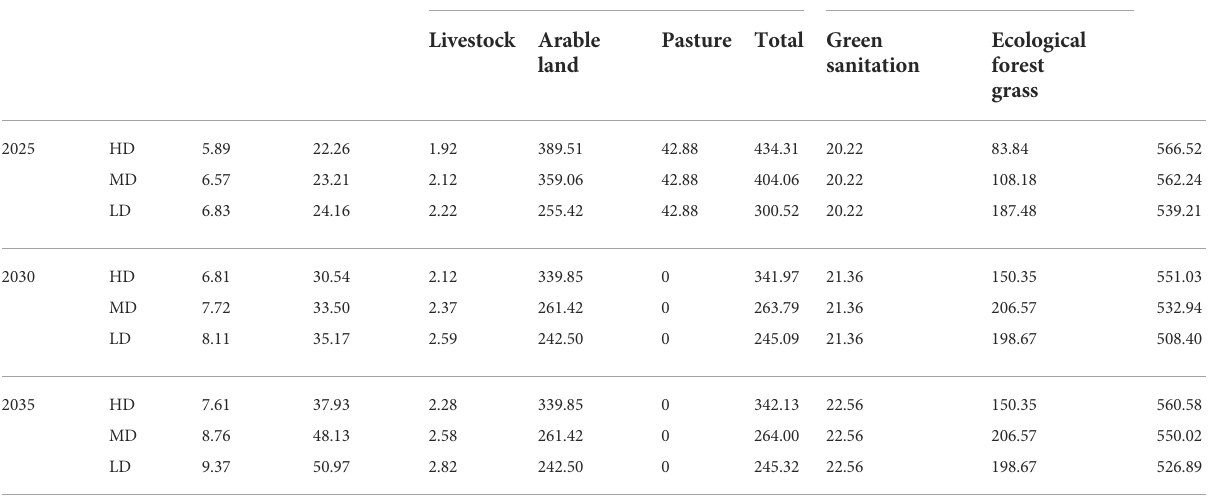
TABLE 2 Water demand schemes of Jinghe County (unit: 10 6 m 3